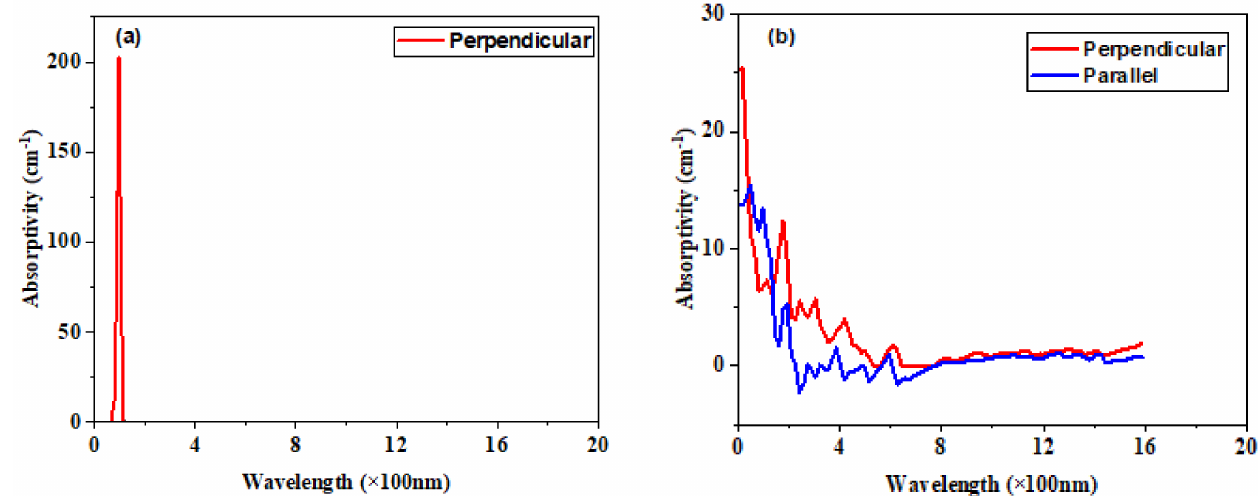
Figure 7. UV-Vis spectra of ( a ) armchair (5, 5) SWBNNT and ( b ) armchair (5, 5) SWCNT